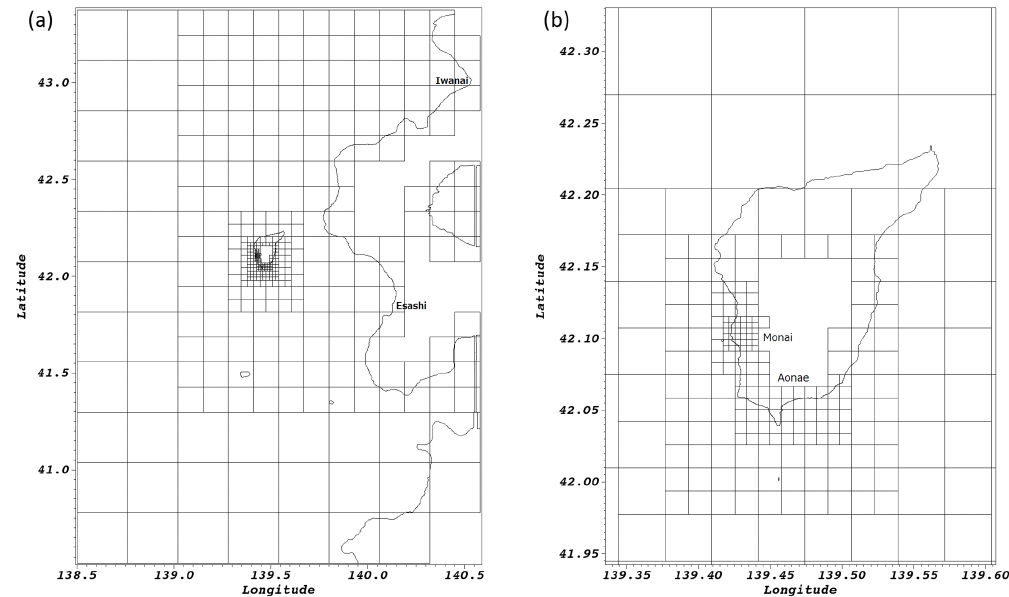
Figure 18. (a) Entire domain-refined mesh containing seven levels. (b) Zoom on Okushiri island. Higher resolution used around Monai Valley at level 7 (7m approx.) and Aonae region at level 6 (14m